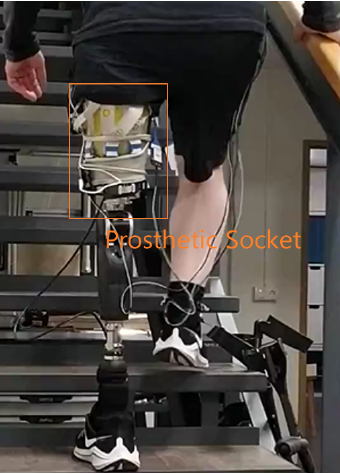
Figure 1. Amputee patient wears a prosthetic